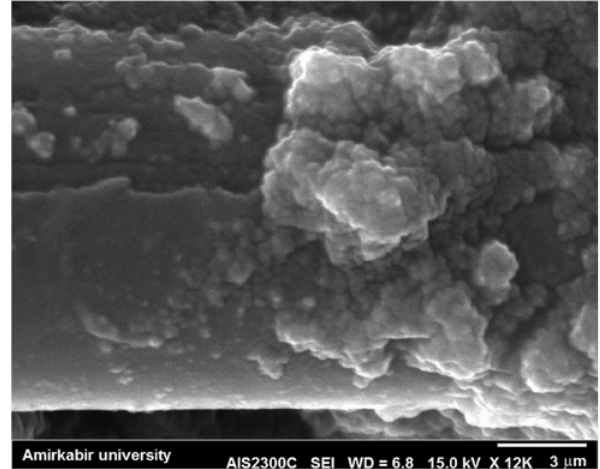
samples without ethanol dilution. 2